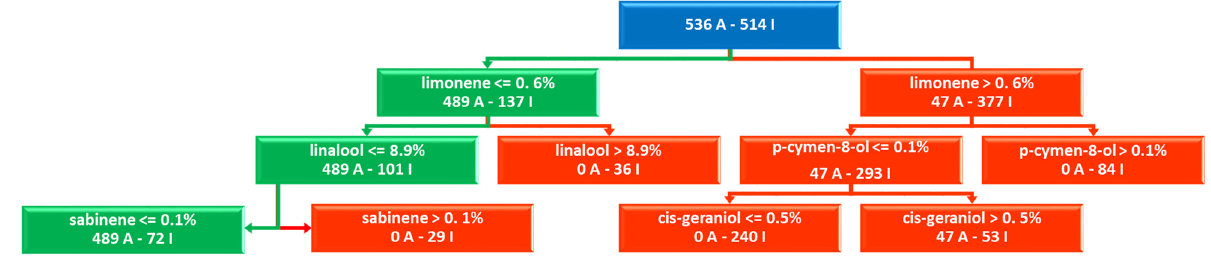
Figure 1. Top 3 levels of the RF first decision tree: most important chemical components from the DA dataset on M. canis bioactivities and EO virtualized chemical composition. The full tree is reported as Supplementary Figure S1. Green path indicates positive impact on M. canis inhibition, while red path, negative influence. The blue box indicates the starting DA dataset composition. In this tree limo-nene, linalool, and sabinene are indicated to be important but at low concentrations (lower than 0.6%, 8.9%, and 0.1%, respectively).